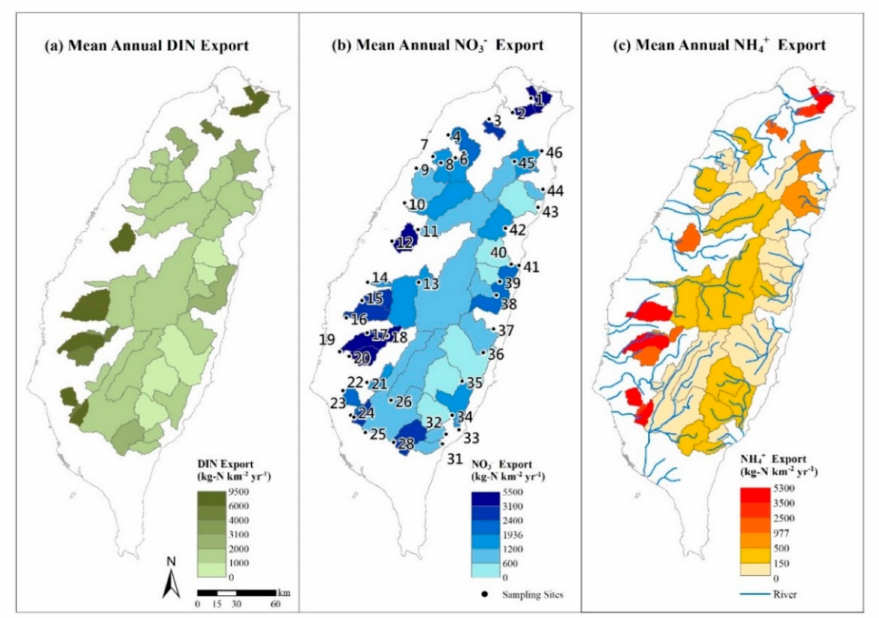
Figure 3. The spatial patterns of DIN ( a ), NO 3 − ( b ) and NH 4 + ( c ) exports of 43 watersheds. The numbers in panel ( b ) indicate the sampling sites. Table 3. Mean estimated seasonal NO 3 − , NH 4 + and dissolved inorganic nitrogen (DIN) concentrations and exports for 43 sampling sites in the study period (unit: mg-N L − 1 for conc. and kg-N km − 2 yr − 1 for flux). Annual Dry Season Wet Season Conc. Flux Conc. Flux Conc.